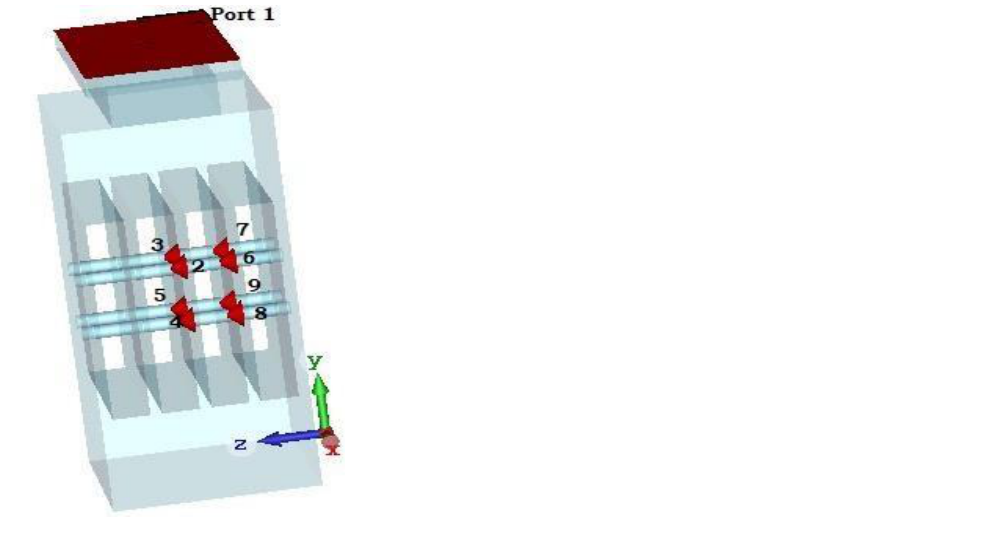
Figure 10. RF cavity considered for simulation: ladder-type multibeam EIK input/output cavities with port.